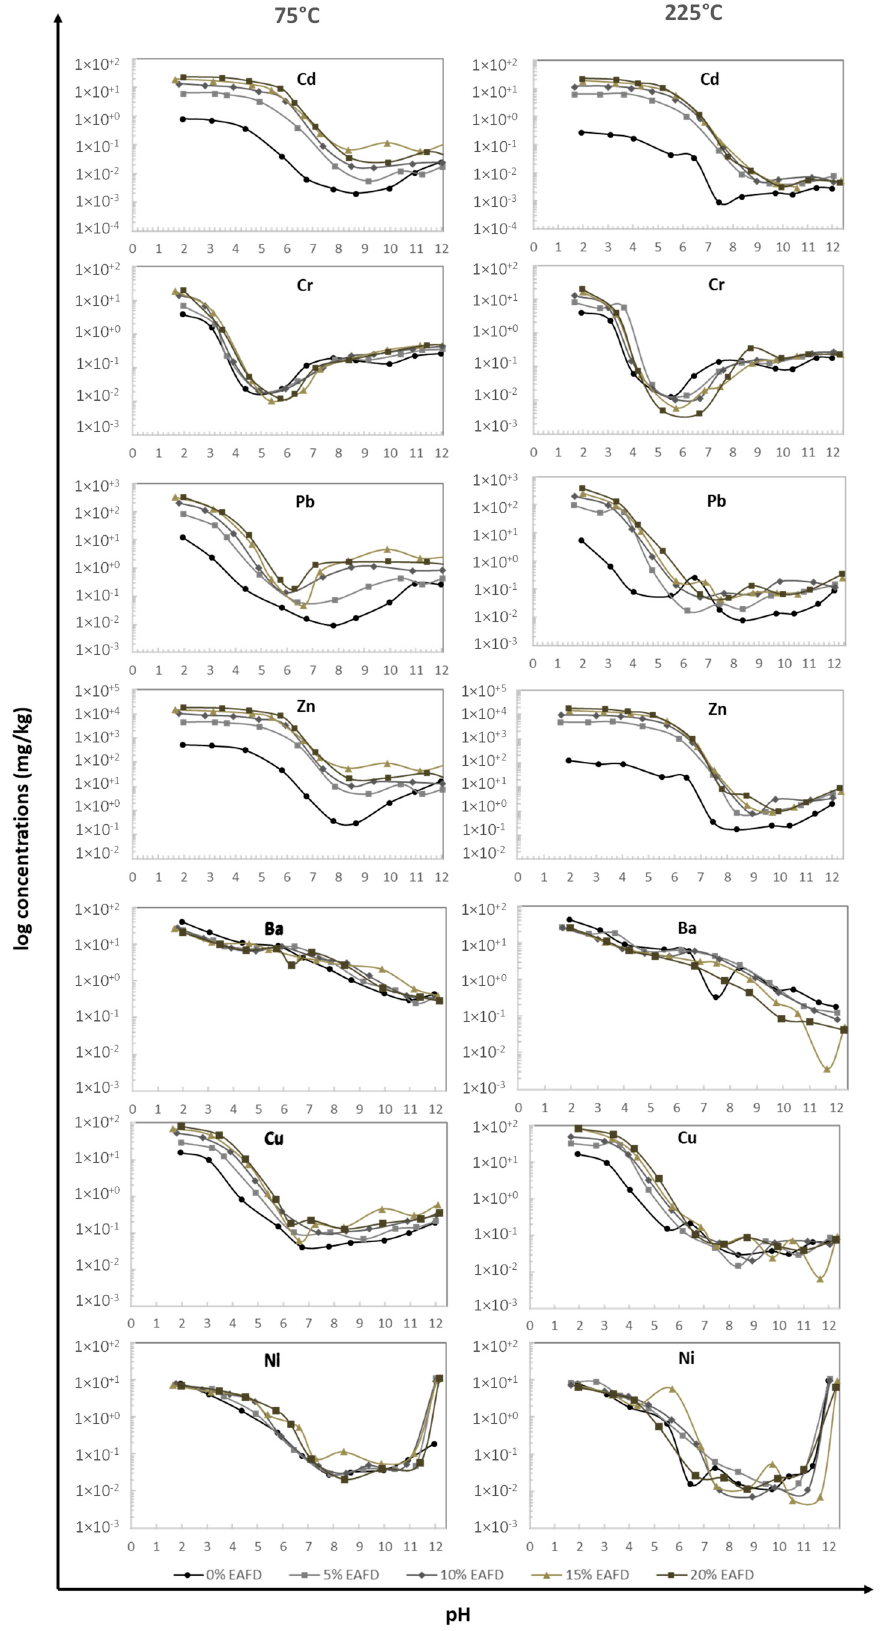
Figure 4. Concentrations (mg/kg) of Cr, Pb, Zn, Cd, Ba, Cu, and Ni in the leachate after the pH dependence test of the geopolymers with EAFD at 75 °C and 225 °C.